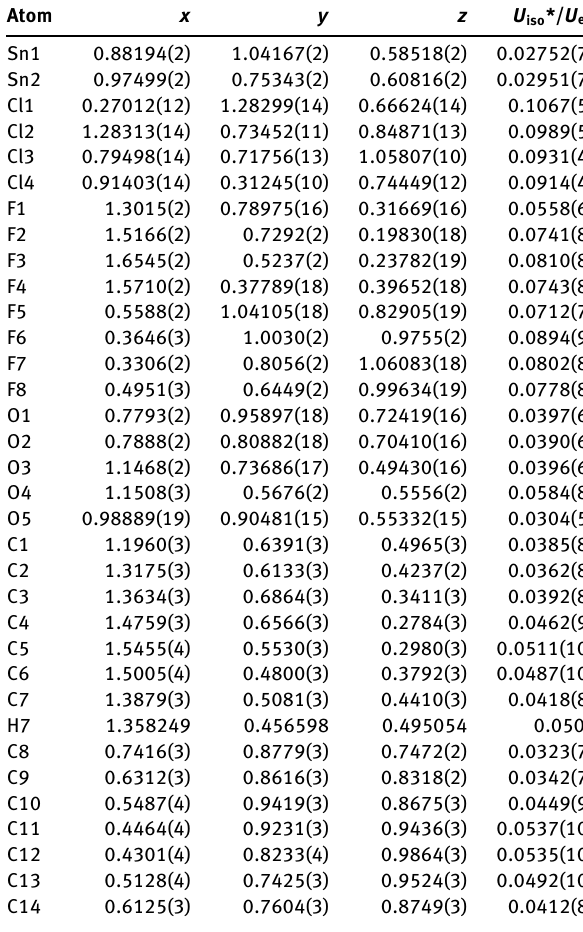
Table 2: Fractional atomic coordinates and isotropic or equivalent isotropic displacement parameters (Å 2